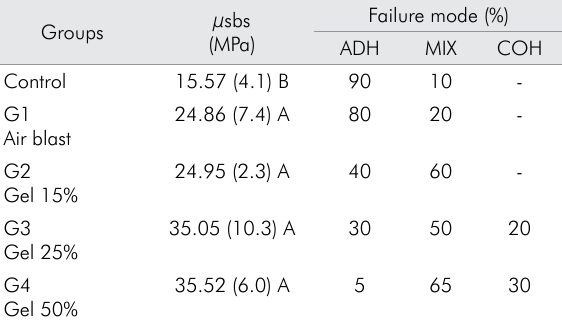
Table 1. Means (standard deviations) for μsbs and SEM classification of the following failure modes: ADH - adhesive; MIX - mixed, involving luting material and ceramic; COH - cohesive, within the luting